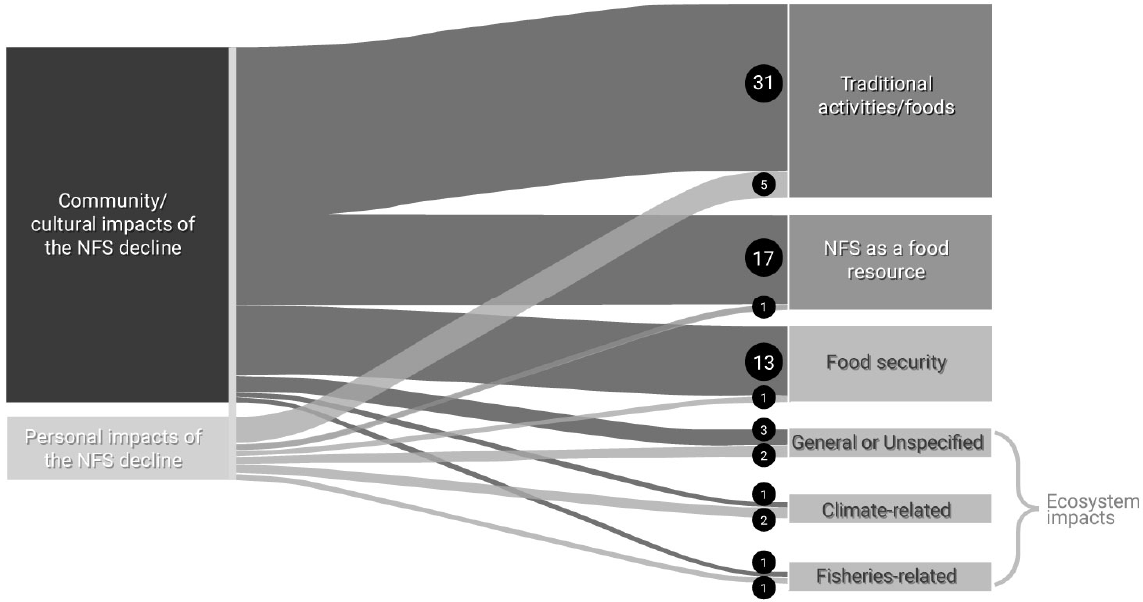
Figure 2. Sankey diagram depicting the co-occurrence frequency of “personal impacts” and “community/cultural impacts” with aspects of the NFS decline in the Pribilof Islands, Alaska. Numbers in and size of black circles denote the frequency of co-occurrences between codes.